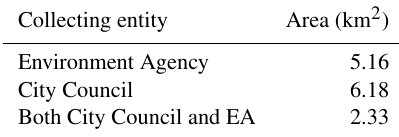
Table 2. Comparison of identified flood